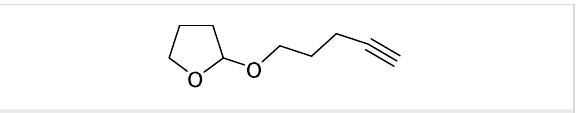
In order to investigate if the presence of the silicon linker was preventing the Pauson-Khand reaction occurring, a test reaction between allyltrimethylsilane and 3-butyn-1-ol was performed using dicobalt octacarbonyl and NMO (Scheme 6). A mixture of cyclopentenone regioisomeric isomers were obtained, with the principal regioisomer being the one shown in Scheme 6.